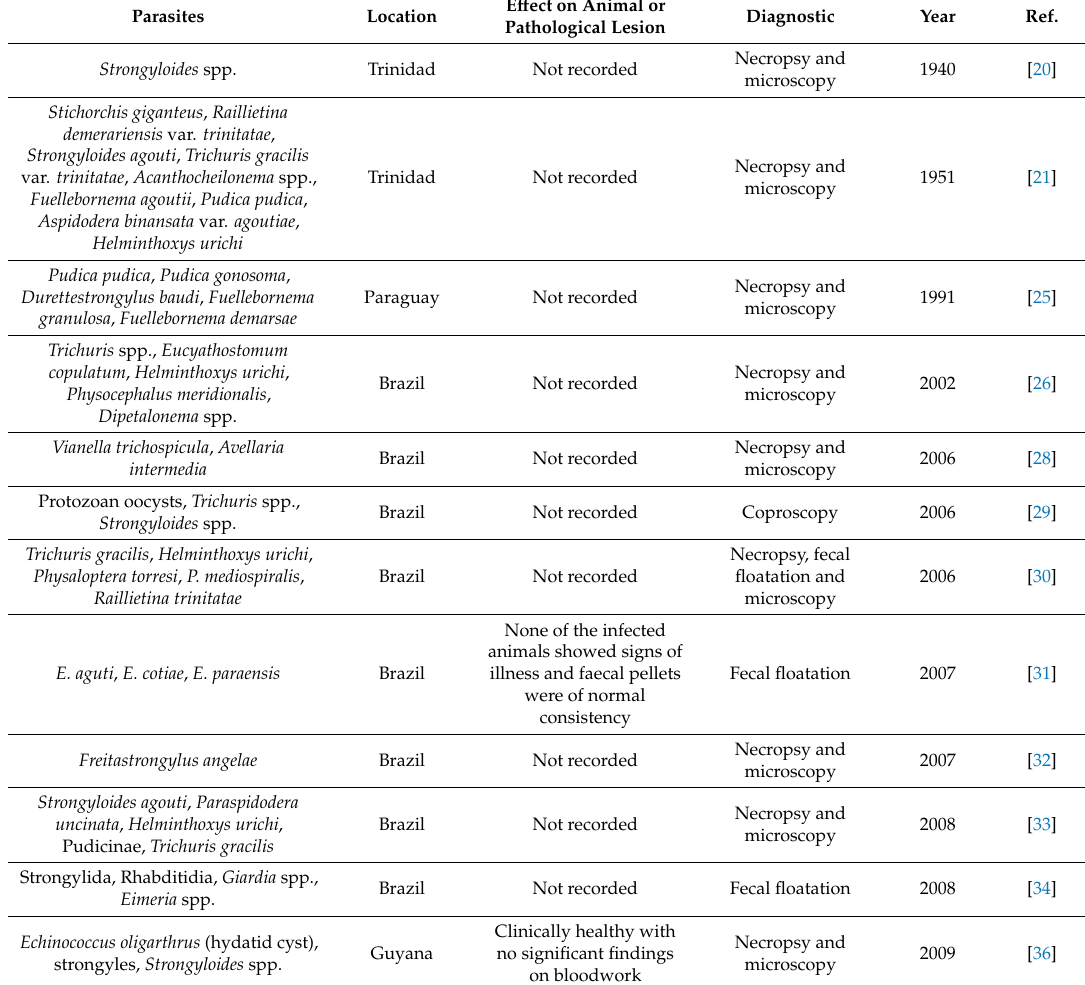
Table 1. Endoparasites found in the agouti ( Dasypocta spp.) at di ff erent locations and points in time. E ff ect on Animal or Parasites Location Diagnostic Year Ref. Pathological Lesion Strongyloides spp. Trinidad Not